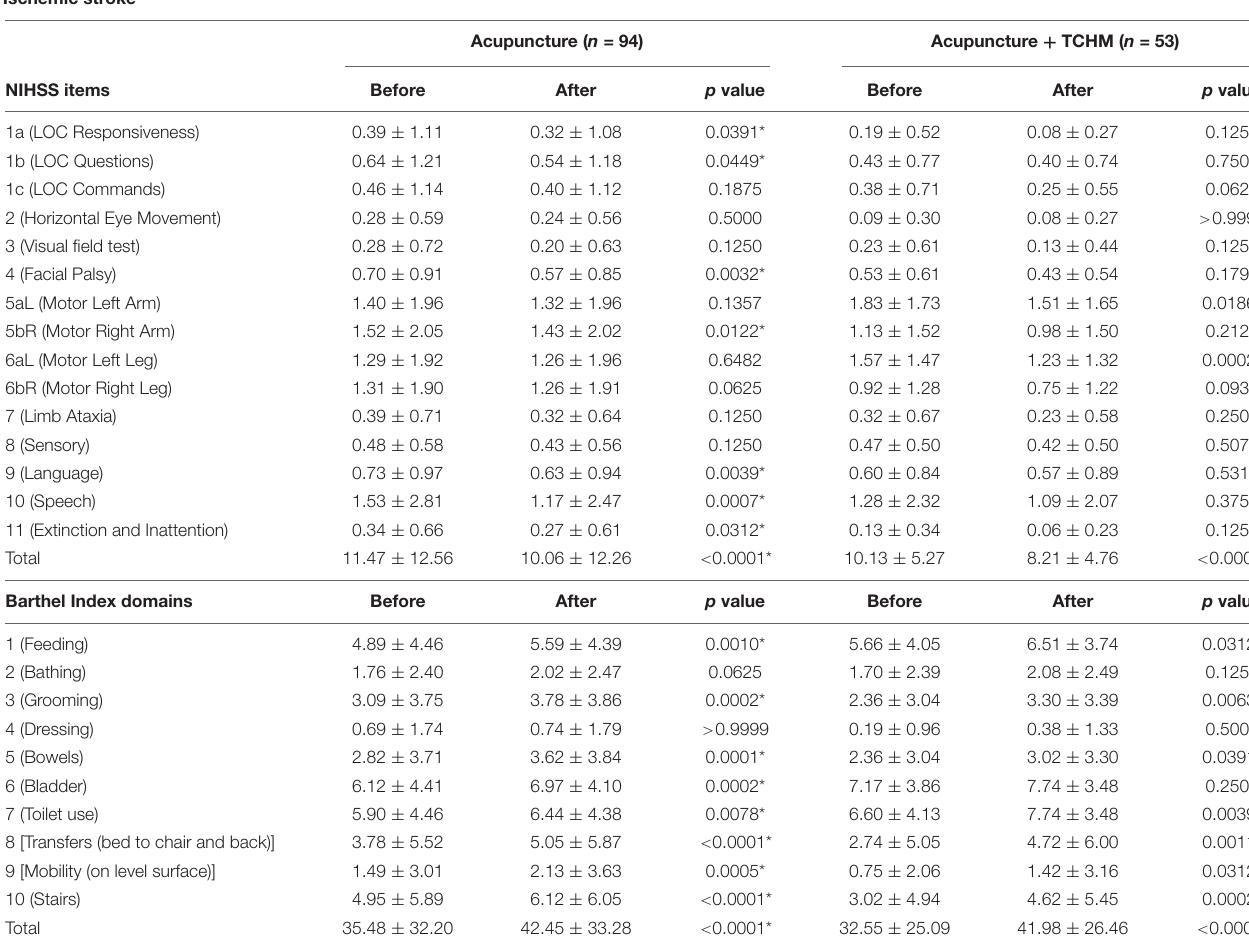
TABLE 3 | NIHSS and Barthel Index scores in ischemic stroke patients with ITCWM-stroke care. Ischemic